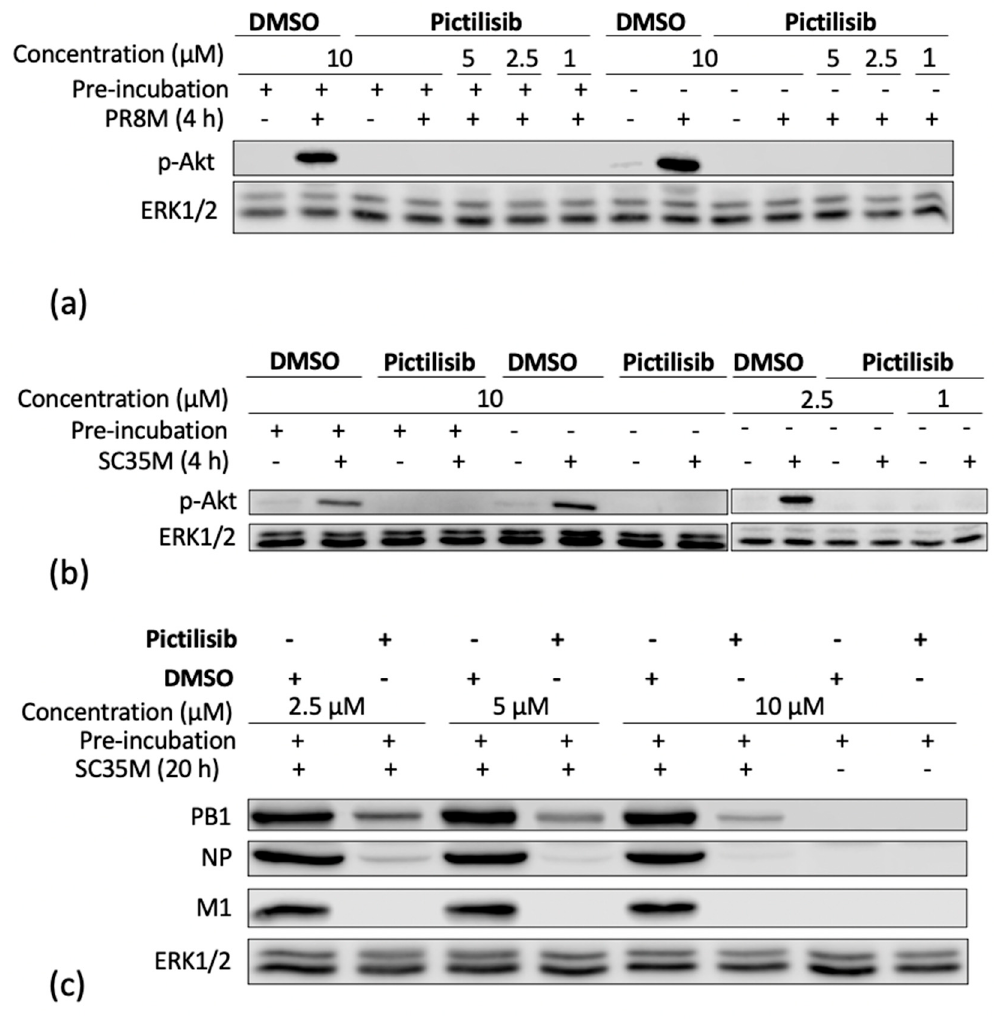
Figure 2. Pictilisib efficiently inhibits IV-induced Akt activation and affects early stages of viral infection. A549 cells were left untreated or pre-incubated with the indicated concentrations of Pictilisib or solvent control (DMSO) for 30 min prior to infection with influenza PR8M (H1N1) (MOI 5) ( a ) and the recombinant SC35M (H7N7) ( b : MOI 5; c : MOI 0.001). After 30 min of infection, viral inoculum was removed, and cells were supplemented with medium containing Pictilisib or DMSO. After the indicated times, cell-lysates were prepared and applied to protein detection by Western blot analysis. Activation of PI3K-mediated signaling was monitored by phosphorylated Akt (Ser473). Equal protein loading of the kinase was verified by detection of ERK1/2. Ongoing viral replication was demonstrated by accumulation of the viral proteins in two (NP, M1) or three (PB1) independent experiments.